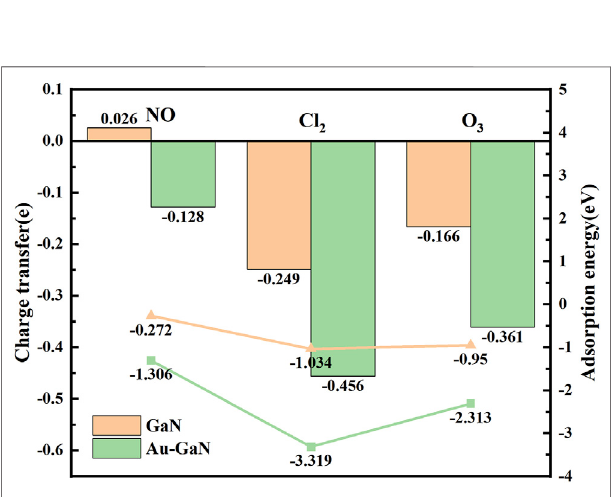
FIGURE7| ChargetransferandadsorptionenergyofGaNandAu – GaN adsorption systems (the bar diagram represents the charge transfer, and the broken line diagram represents the adsorption